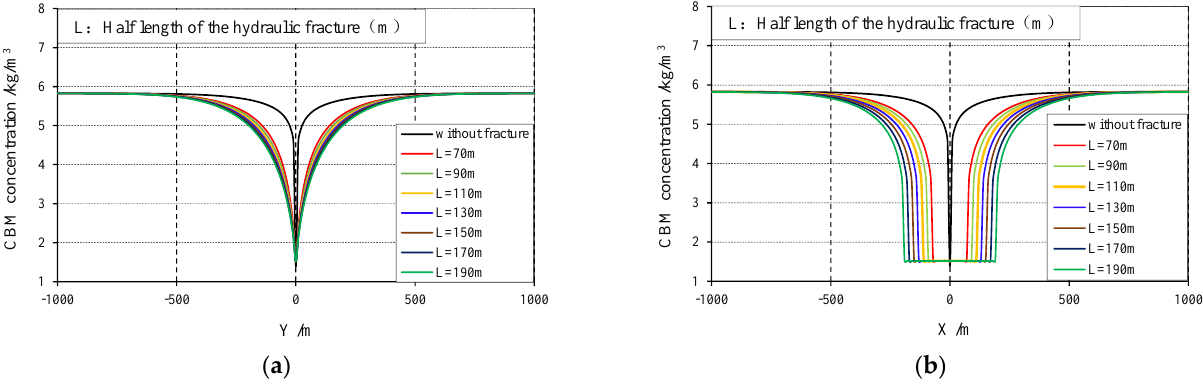
Figure 13. CBM concentration when different fracture lengths on the profile lines after 5 years of extraction. ( a ) profile line 1 and ( b ) profile line 2.